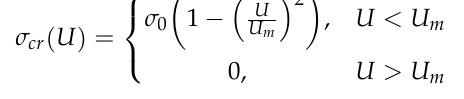
Figure 9. Stabilised value of impedance ( a ) and skin ( b ) versus the connate water saturation.